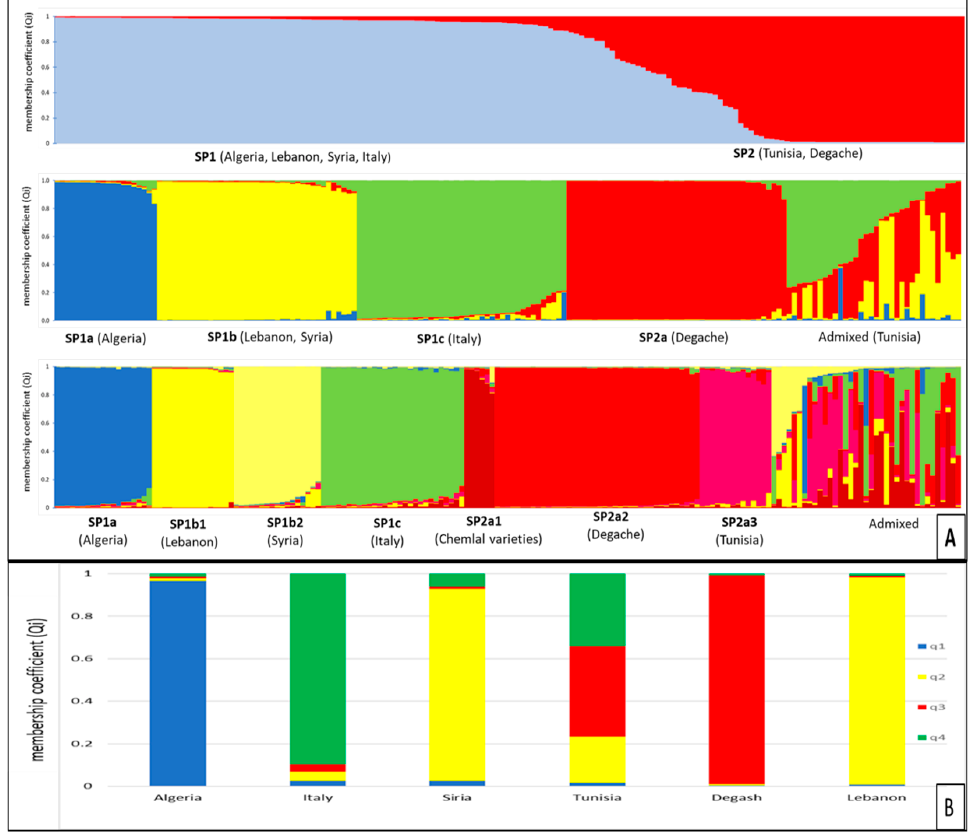
Figure 4. ( A ) Bayesian inference of population structure based on 10 microsatellite loci in 177 olive accessions, for K = 2 (the most probable genetic structure model), K = 4, and K = 7, inferred with a model-based clustering method implemented in STRUCTURE v.2.3.4. q is the membership coe ffi cient. ( B ) The stacked bar plots showing, for olive populations originating from di ff erent geographical areas, the estimated membership coe ffi cient (qi) relative to the subpopulations identified by STRUCTURE for K = 4.